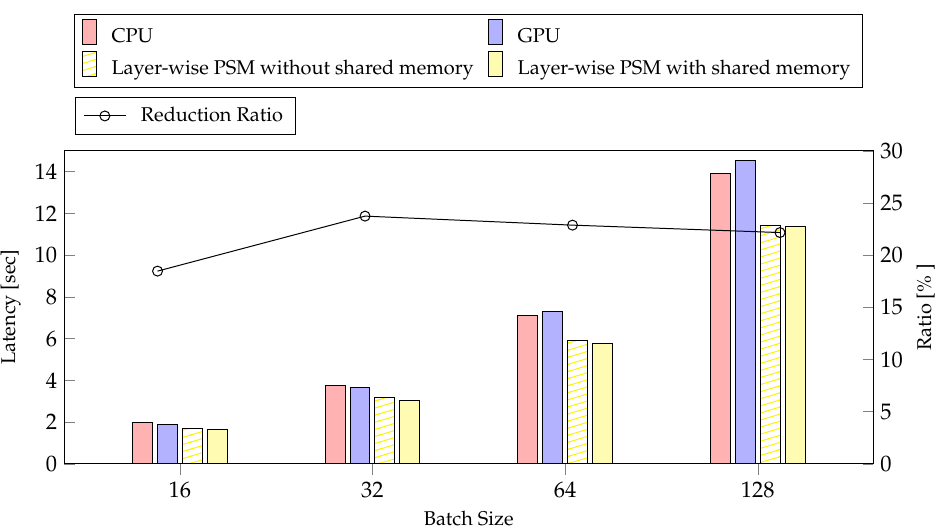
Figure 12. The result of latency executed our method on inference according to batch size. The reduc- tion rate compared our method to the